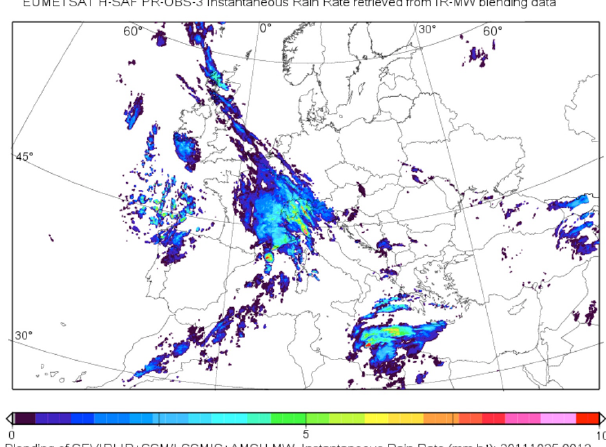
Fig. 3. Example of PR-OBS-3 precipitation rate on 25 October 2011 at